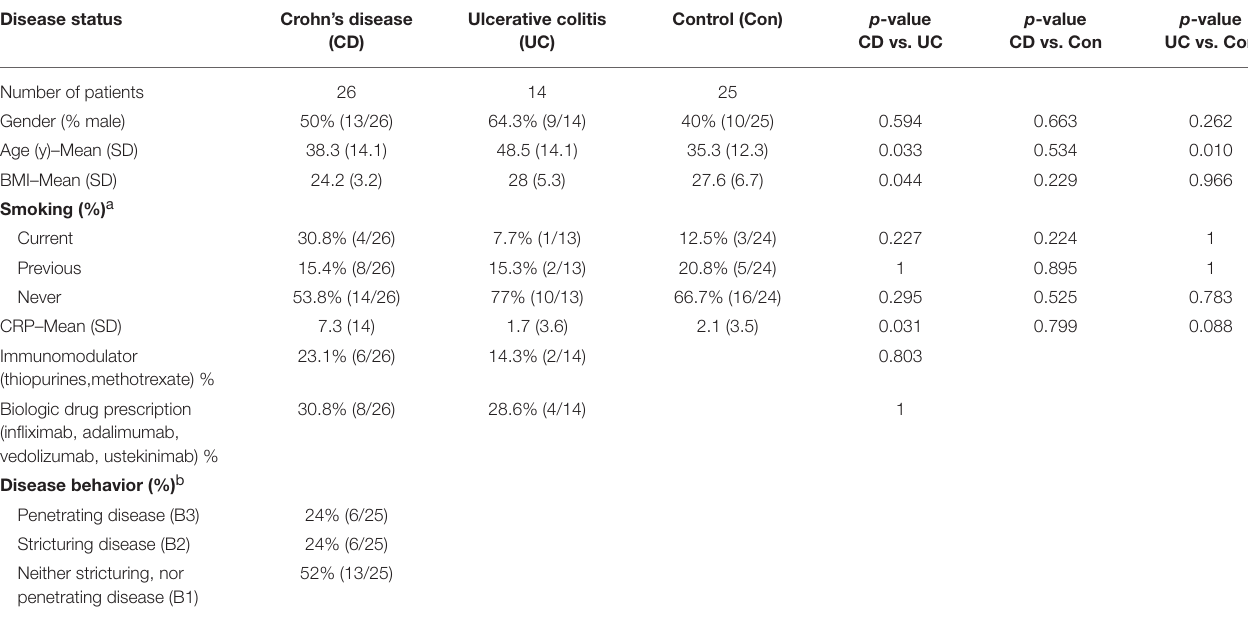
TABLE 1 | Participants for NF- κ B-regulated luciferase activity-based screening studies were recruited from outpatient clinics at The Royal Liverpool and Broadgreen University Hospitals NHS Trust, UK and University Hospital Aachen, Germany. Disease status Crohn’s disease